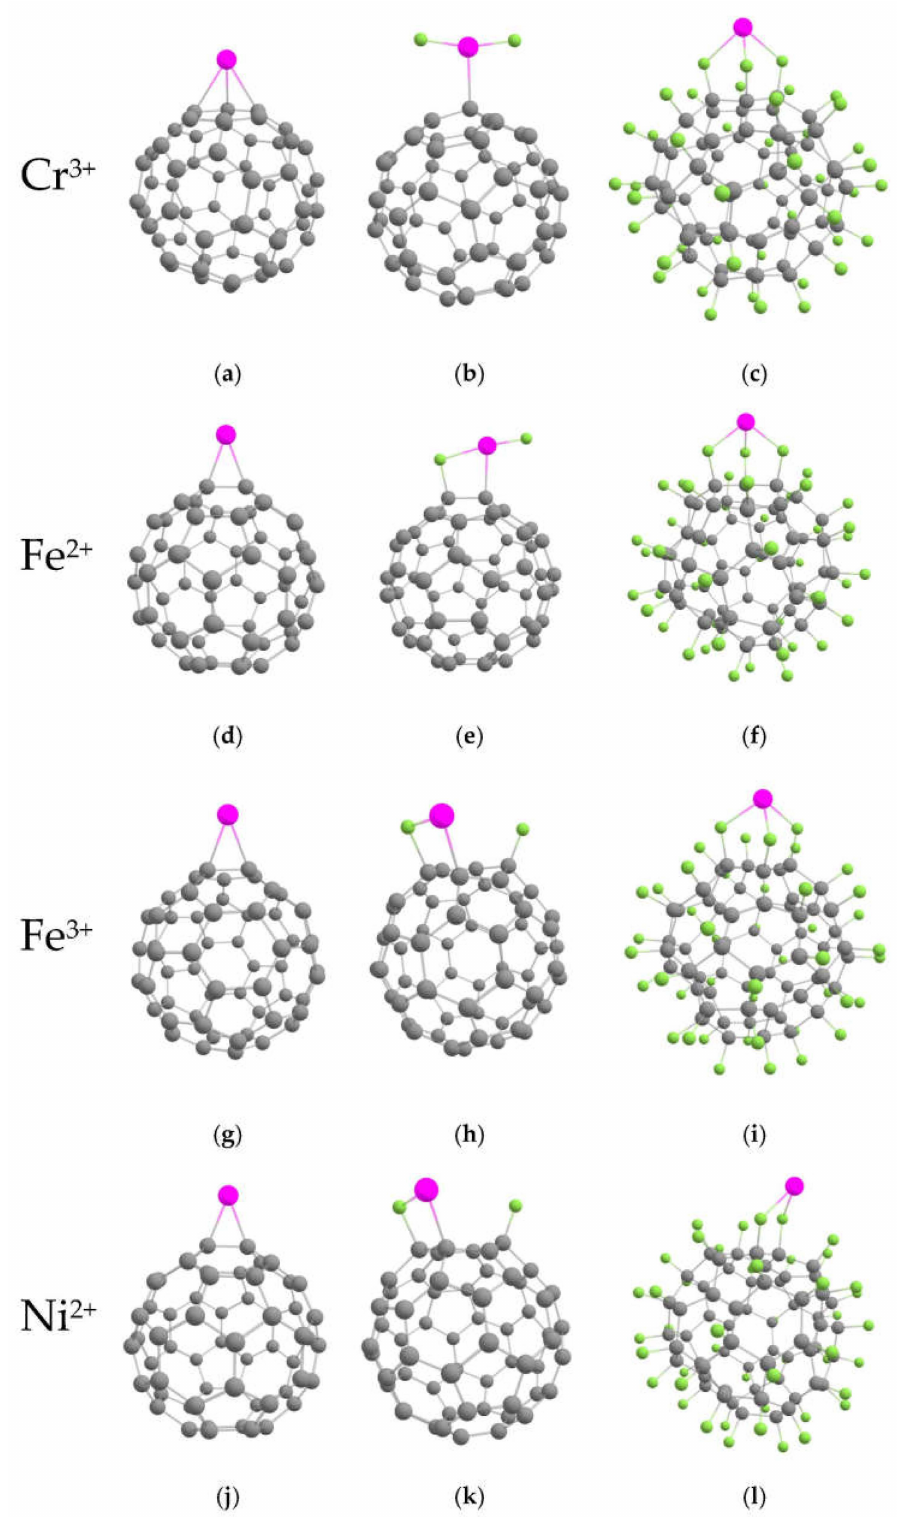
Figure 3. Optimized geometries of pristine, low- and high-fluorinated C 60 decorated with metal